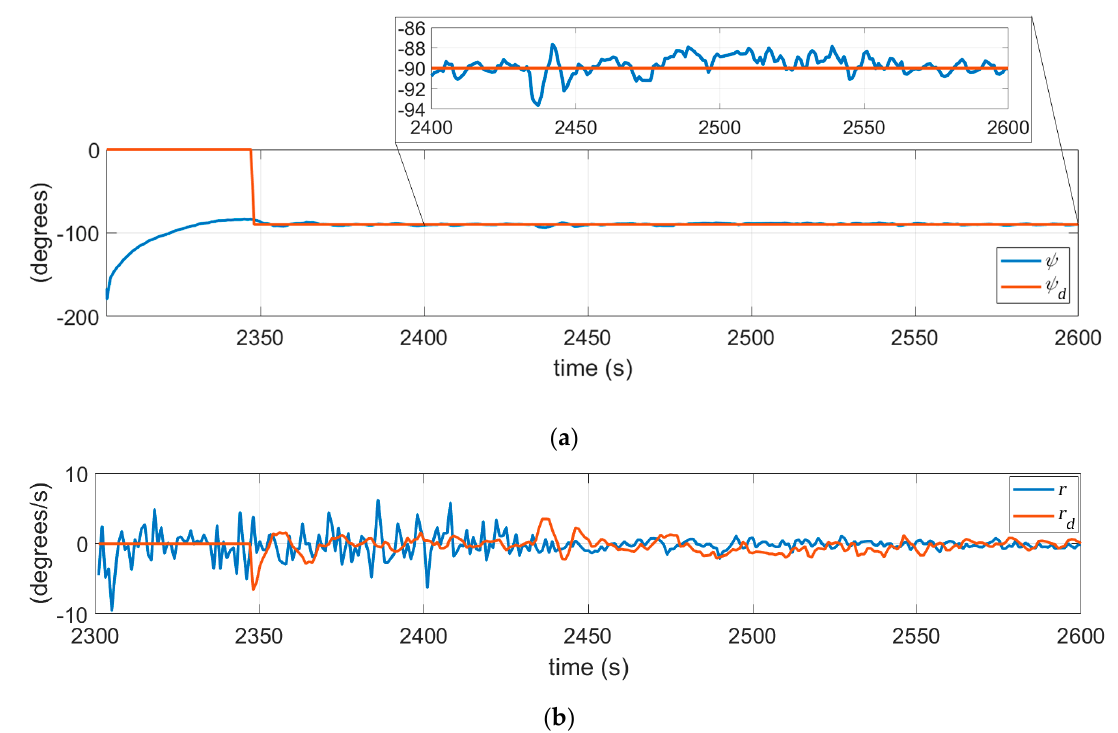
Figure 18. One cycle of gliding test in the sea: ( a – d ) descending motion and ( e – h ) ascending motion.